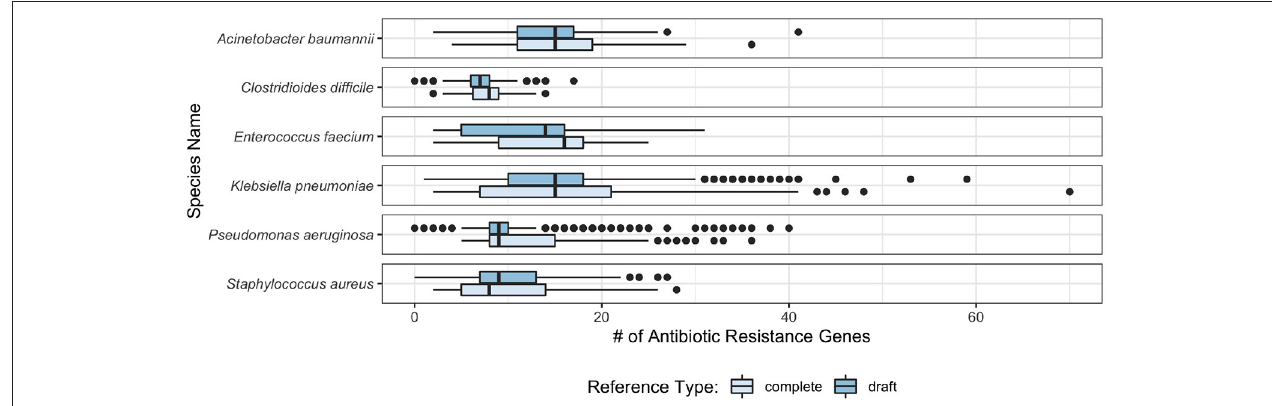
FIGURE 4 | Box plot of the number of AMR genes found per genome in ESKAPE+C pathogens in complete and draft genomes.